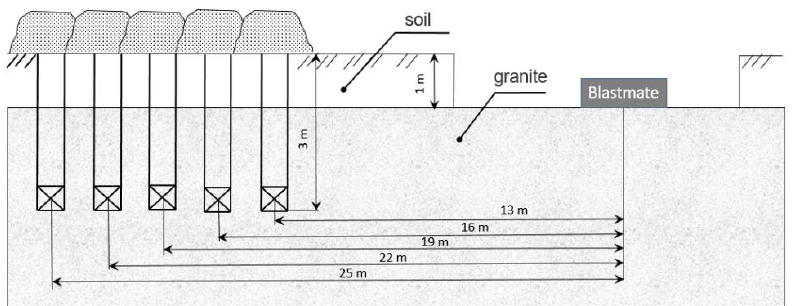
Figure 1. The experiment layout.